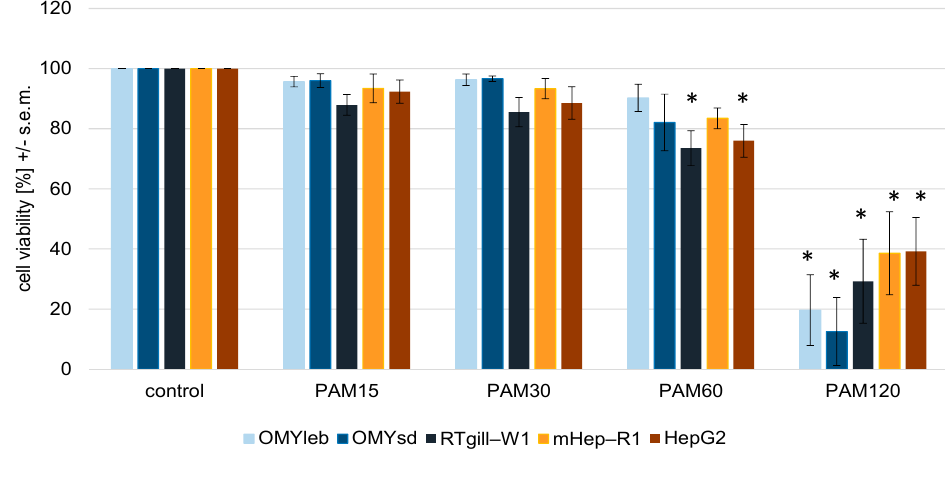
Figure 2. The influence of plasma treatment on cell viability in cultures with similar cell numbers. Cells (at a density of 2 × 10 4 ) were grown under identical medium conditions ( n = 4). Short treatment times up to 60 s resulted in a marginal reduction of cell viability. Cell viability reduced significantly after treatment times of 120 s. The percentage cell viability is given on the ordinate, the different treatments are indicated along the abscissa. The cell lines investigated are colour-coded according to the legend below the graph.